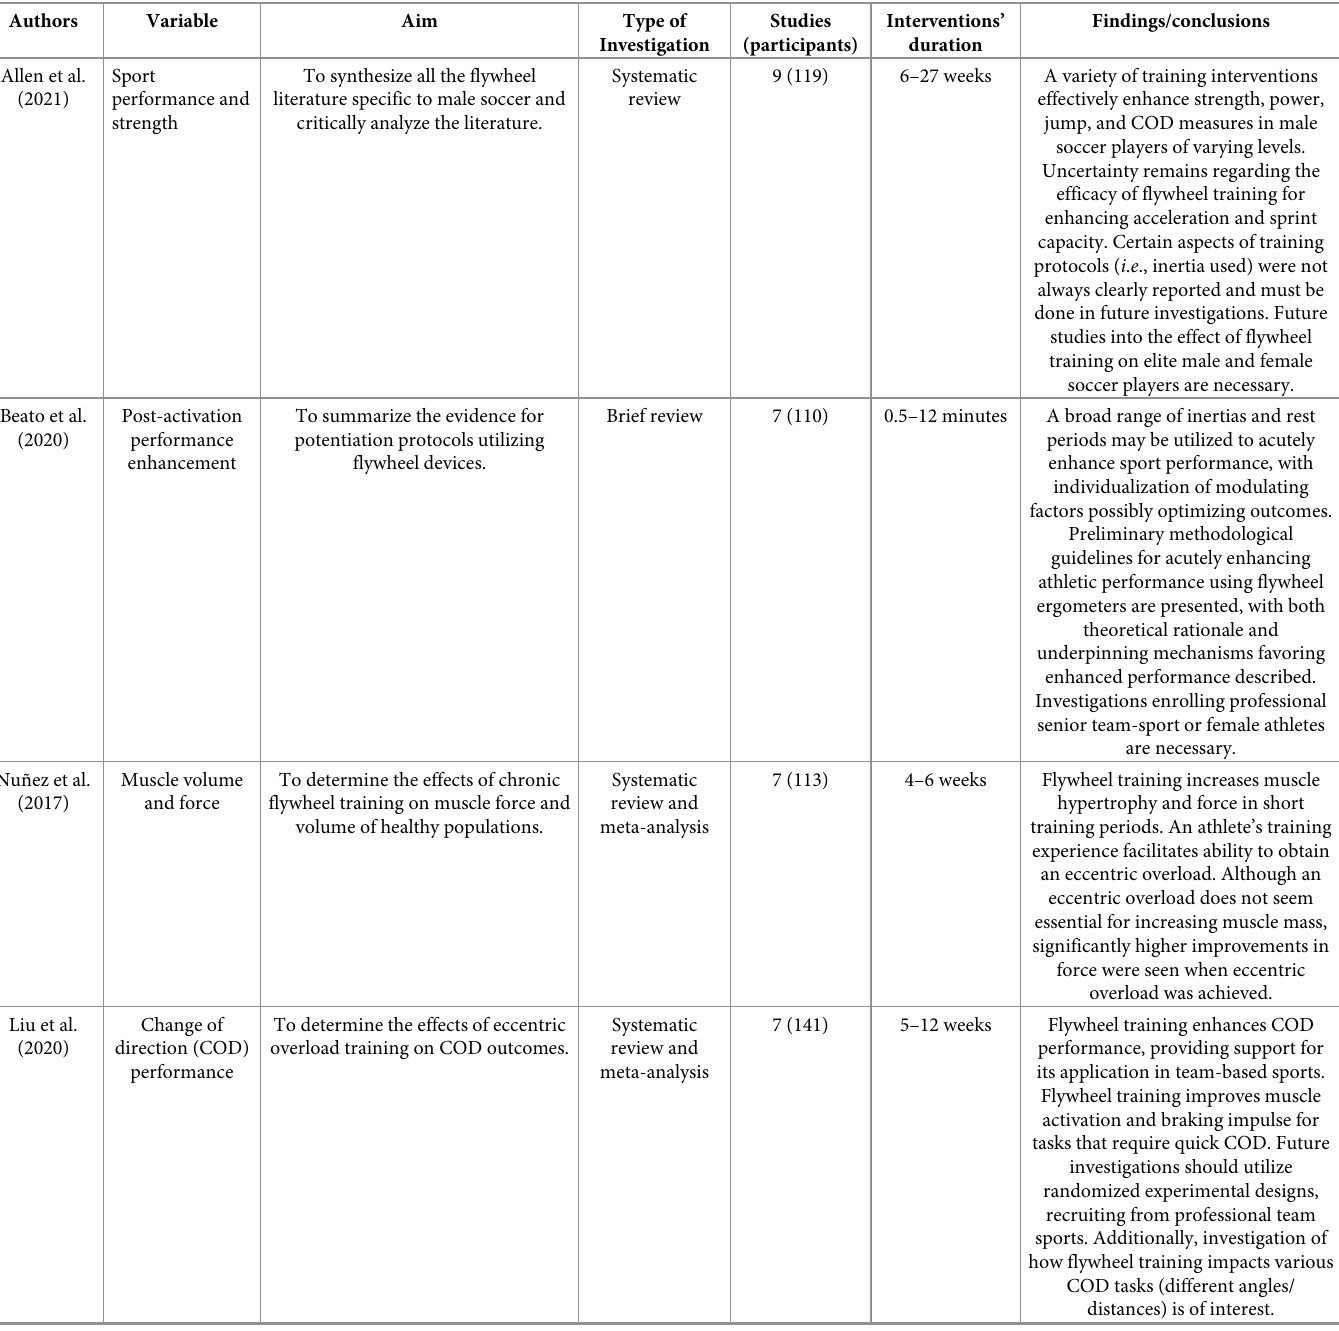
Table 1. Summary of reviews that investigated the effects of flywheel training on physical capacity and